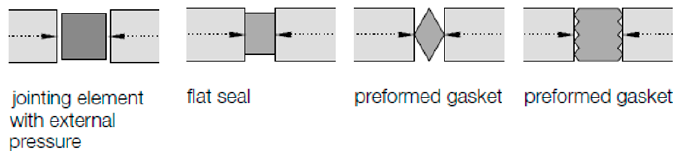
Figure 1. Gasket and jointing element sealing principles [11].